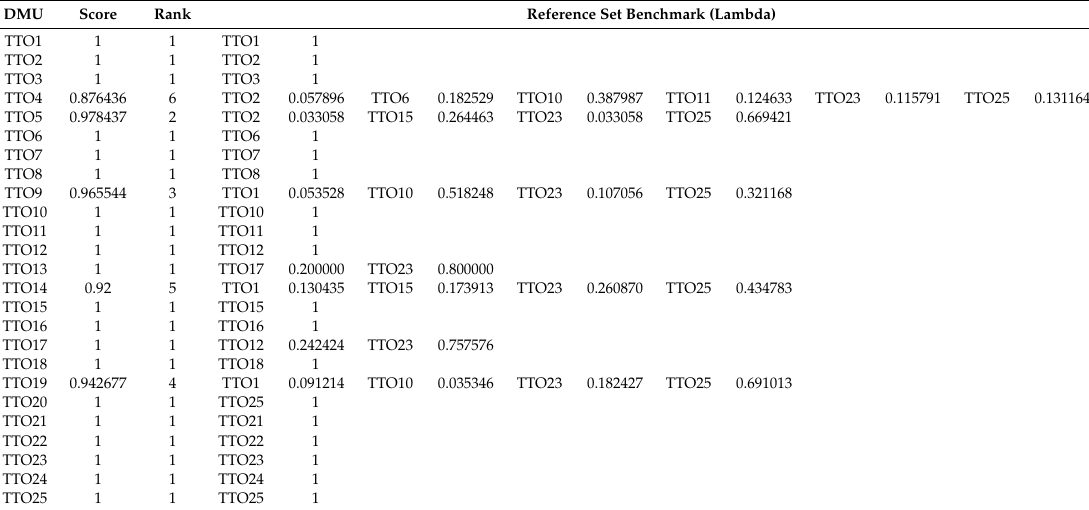
Table 7. Decision-making units (DMU) relative e ffi ciency